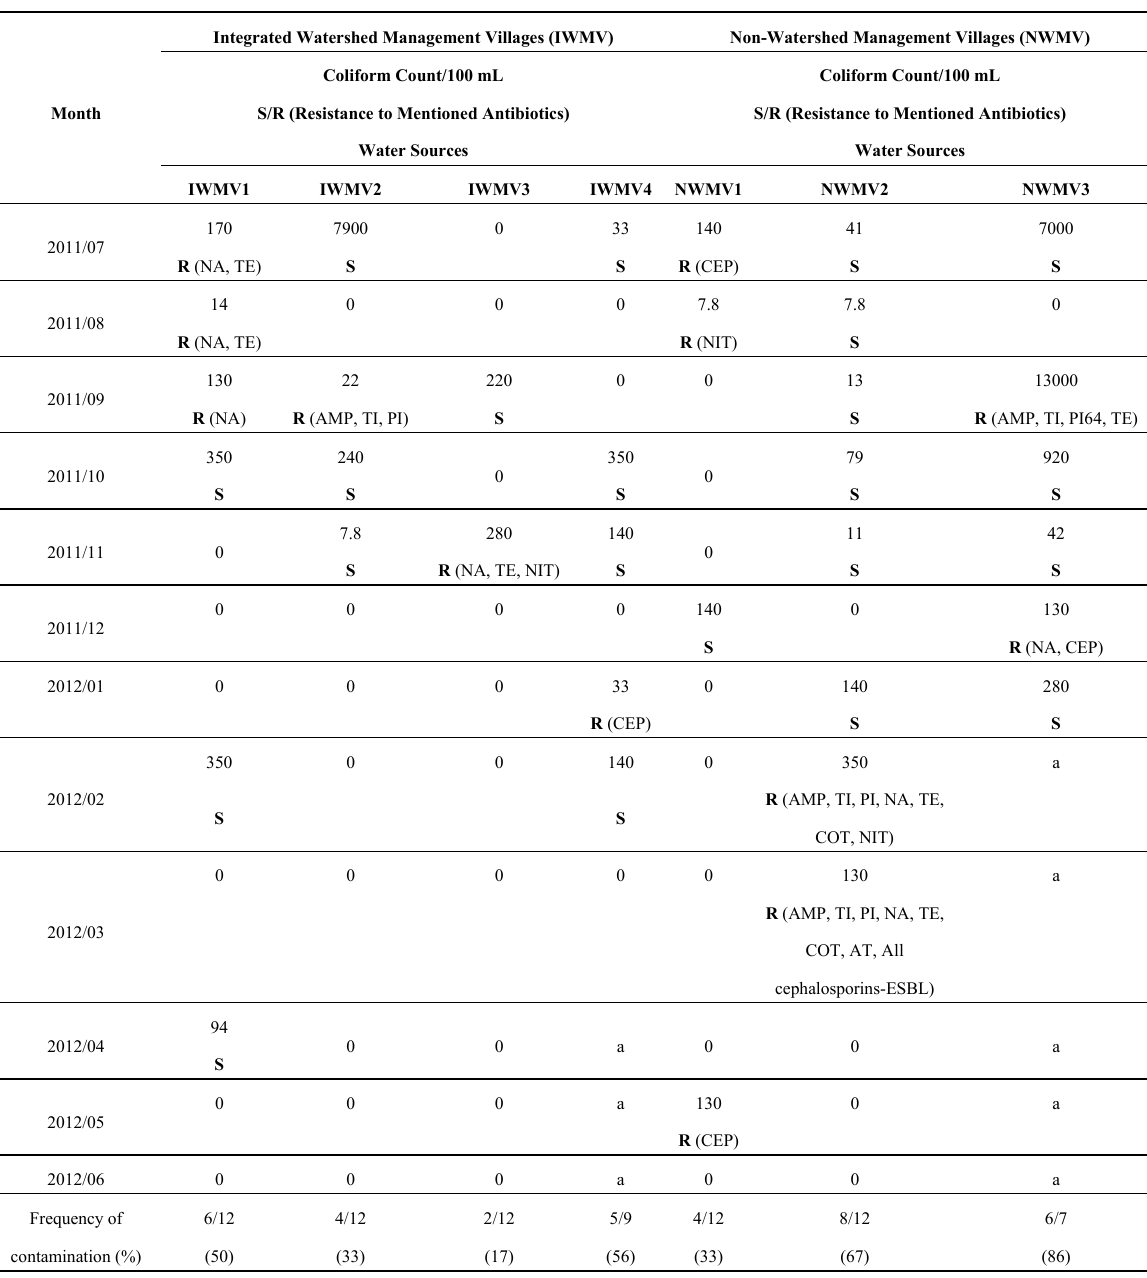
Table 2. Month-wise coliform count/100 mL water and antibiotic resistance of Escherichia coli isolated from water sources of tribal villages with and without implementation of integrated watershed management